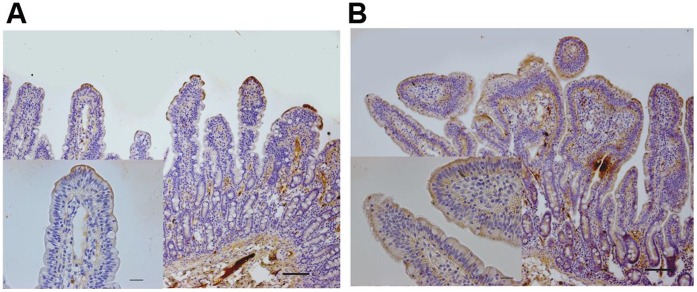
Immunohistochemical localization of TLR4 in jejunal tissues collected from piglets with or without F4+ETEC challenge.(A) Representative microphotographs of DAB-stained jejunum sections from one piglet that received sterile physiological saline orally at day 15 after weaning. TLR4 was localized in the superficial epithelium limited to the tips of the villi and in the mesenchymal cells within the lamina propria, with scattered positive staining. (B) Representative microphotographs of DAB-stained jejunum sections from one infected piglet at day 7 after F4+ETEC challenge (at day 15 after weaning). Increased TLR4 expression was observed in the epithelial cells of both the villi and the crypts and the mesenchymal cells of the lamina propria. Scale bars, 100 µm, 25 µm.